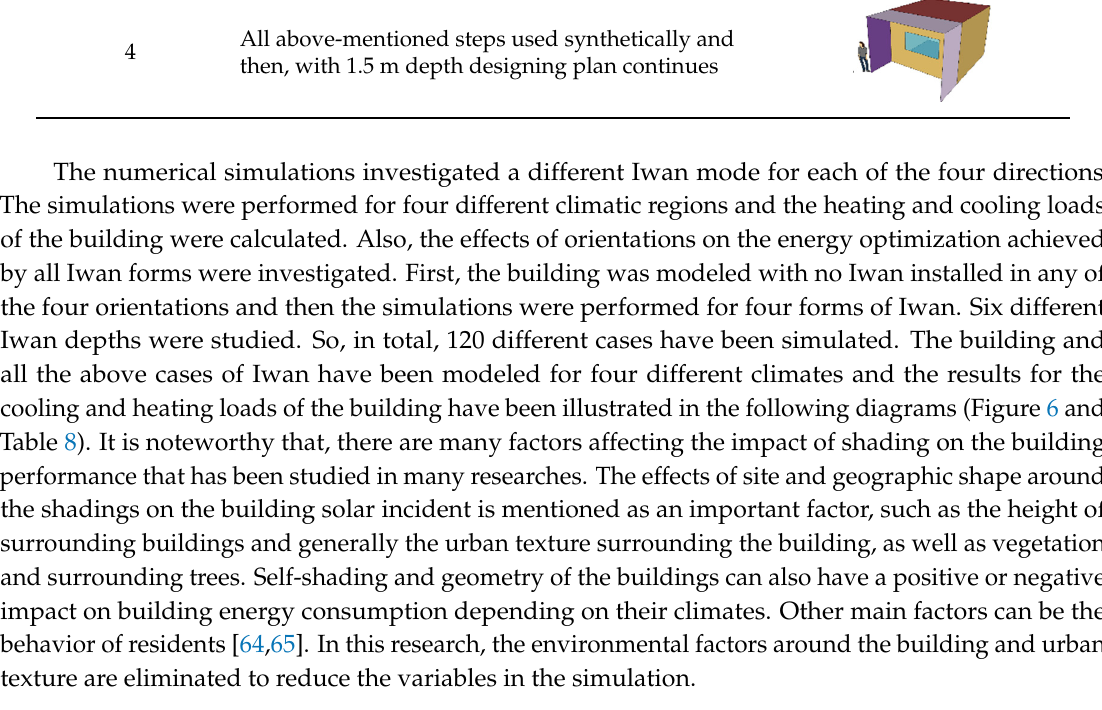
Table 8. Thermal load analysis after Iwan